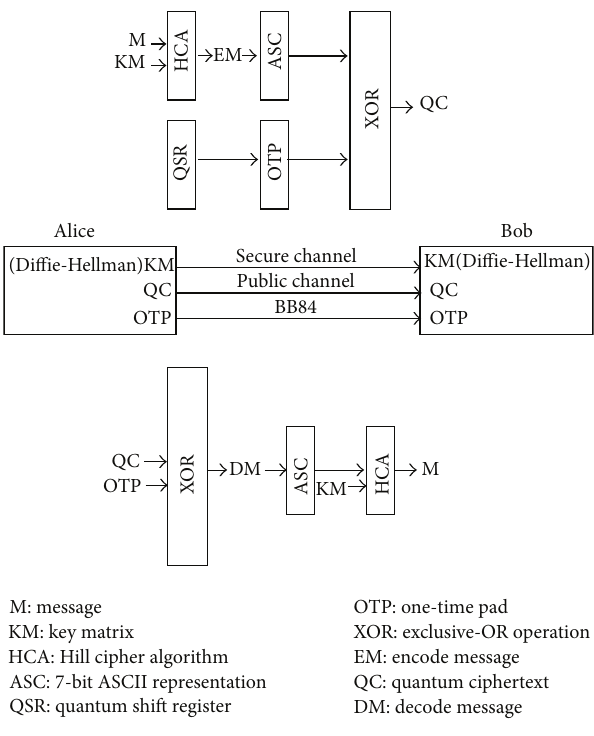
Figure 2: Encryption, transmission, and decryption